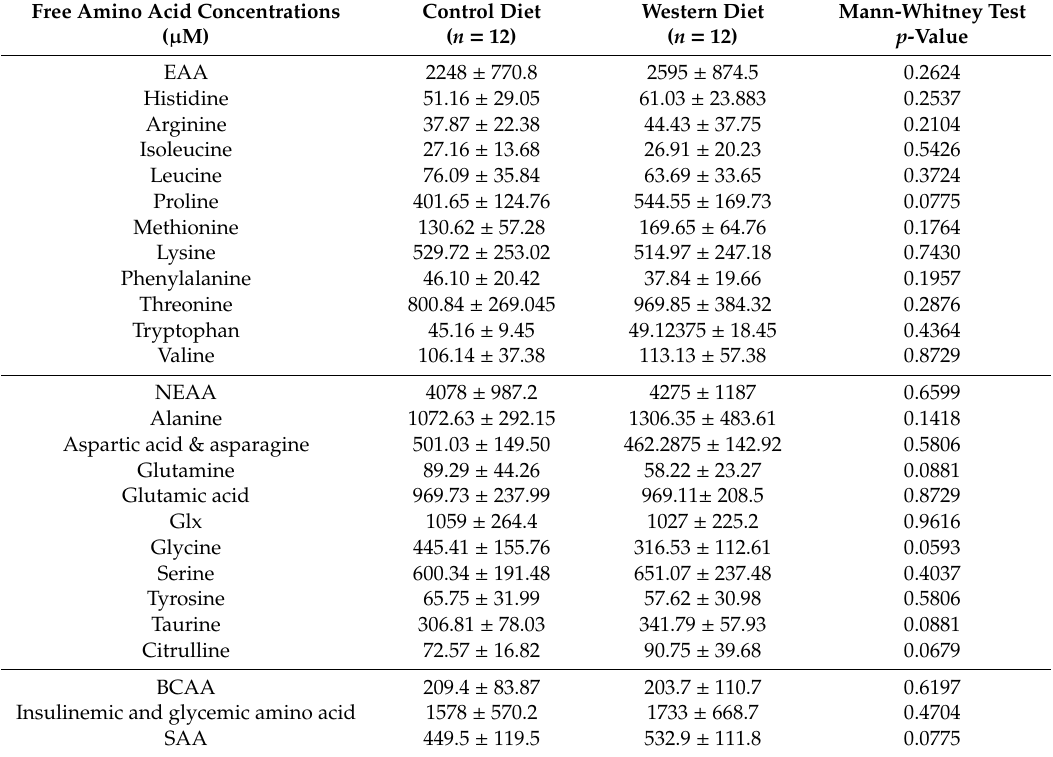
Table 1. Concentration levels of free amino acids in milk ( µ M) provided by dams fed Western vs. Control diet at D20 of lactation